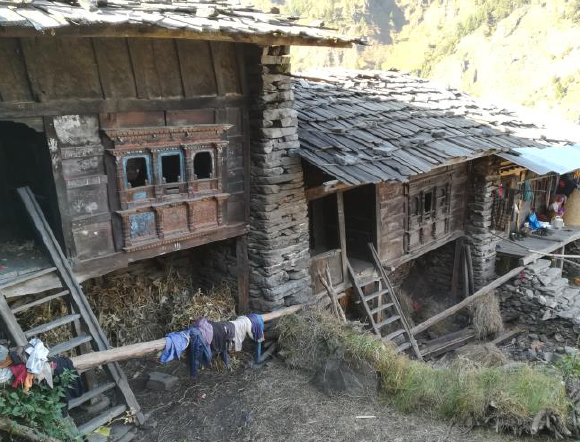
Figure 3. Group of staggered housing